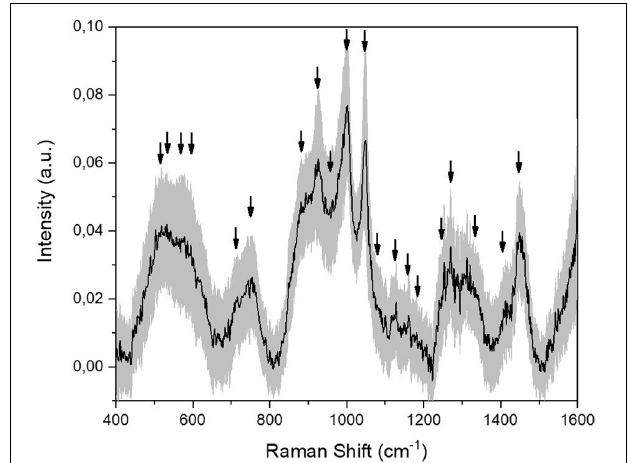
Figure 1 | Average Raman signal obtained from the collected CTRL salivary samples ( n = 33). Black arrows indicate the identified peaks. The gray band represents the standard